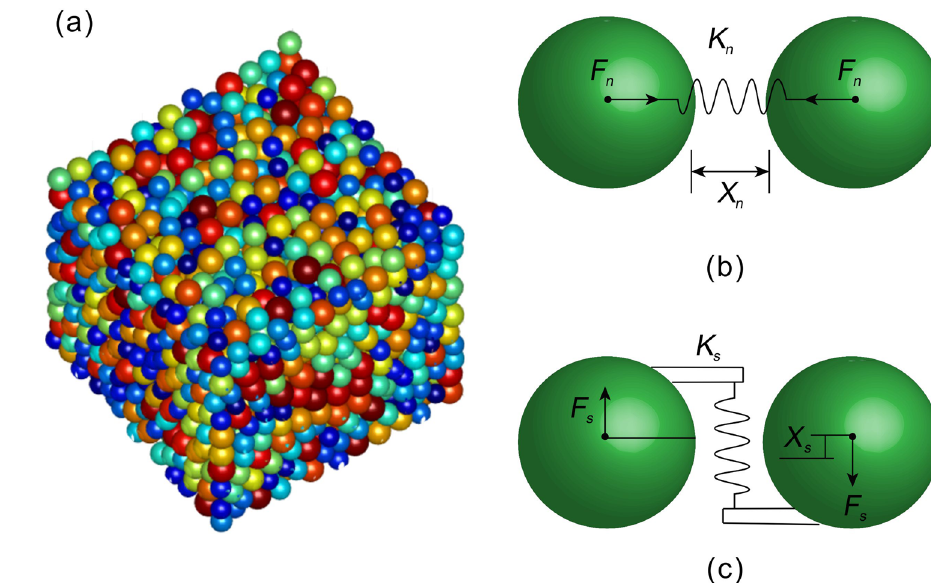
Fig. 2 Schematic diagram of the linear elastic model in the Mat- DEM discrete element method of landslide simulation used in this study. a Elements with specific mechanical properties cemented together; b the normal contact model; c the tangential contact